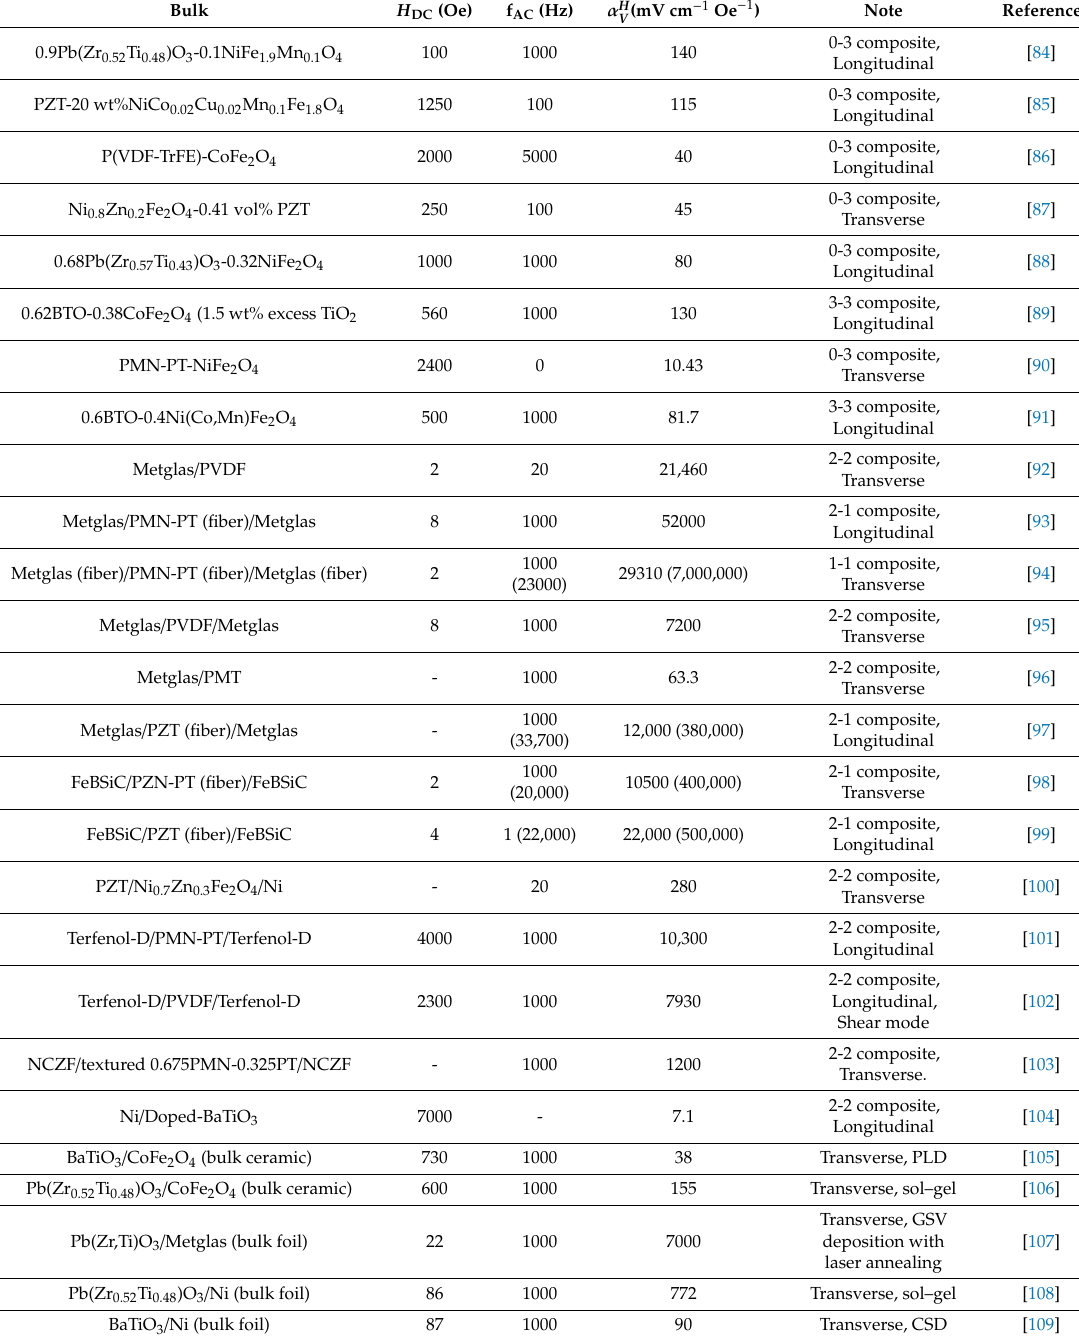
Table 1. Room-temperature α HV value of bulk magnetoelectric